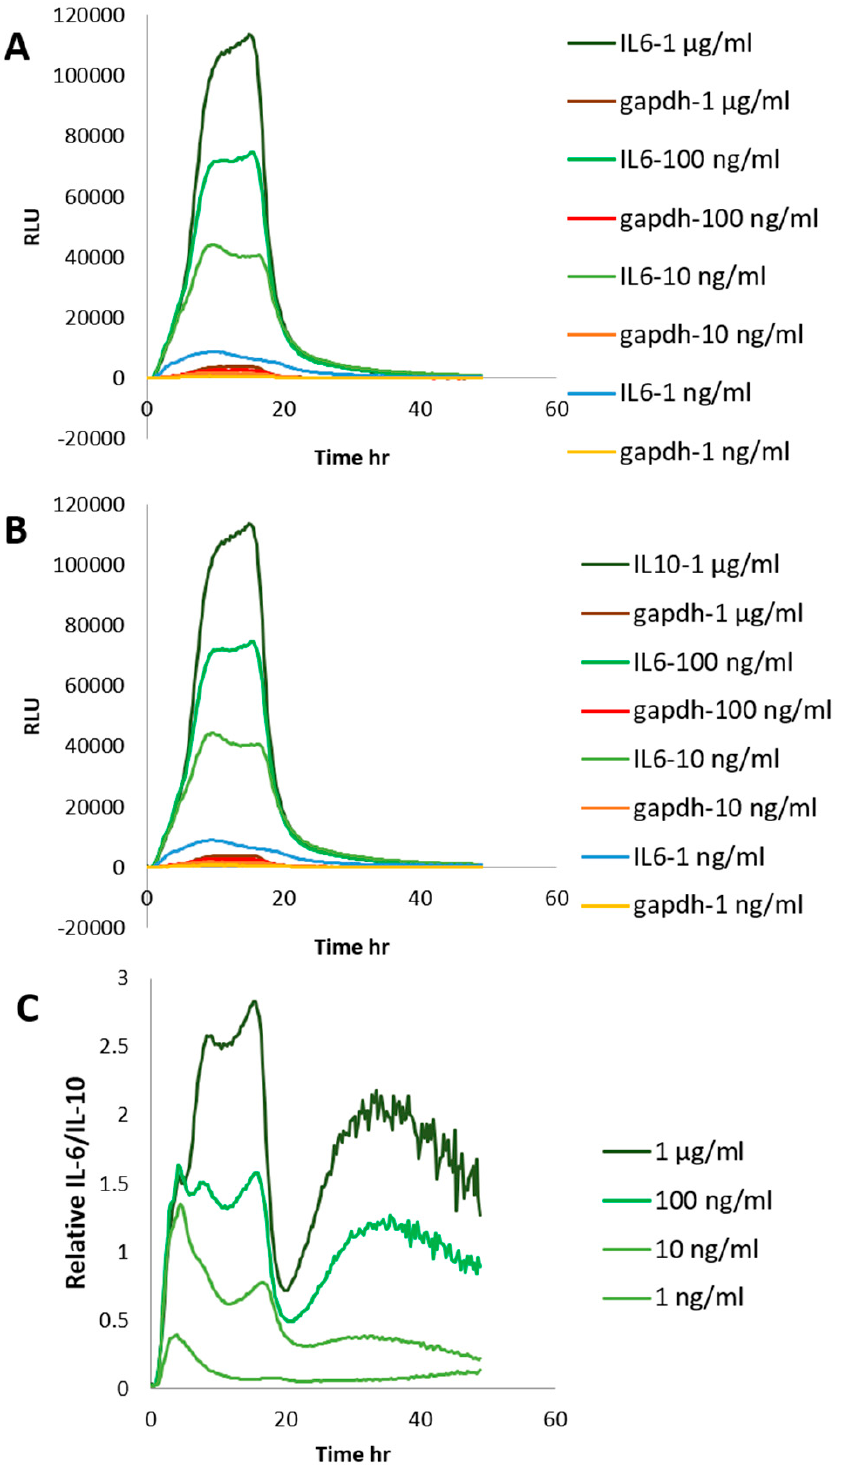
Figure 1. The expression of stable interleukin (IL)-6 / gapdh-RAW264.7 cells and IL-10 / gapdh-RAW264.7 cells by real-time bioluminescence recording. ( A ): Stable IL-6 / gapdh RAW264.7 cells were treated by lipopolysaccharide (LPS) at 1 µ g / mL, 100 ng / mL, 10 ng / mL, and 1 ng / mL. ( B ): Stable IL10 / gapdh RAW264.7 cells were treated by LPS at 1 µ g / mL, 100 ng / mL, 10 ng / mL, and 1 ng / mL. ( C ): Relative IL6 / IL10. The results represent the mean of four representative experiments.